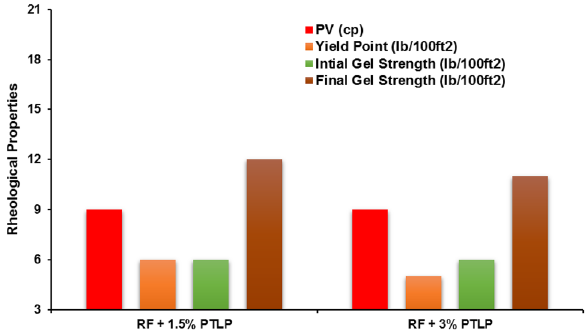
Fig. 6 The influence of PTLP on the rheological properties (aged conditions)